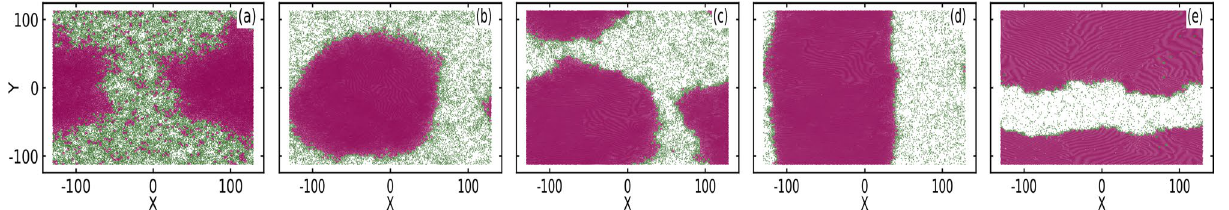
Figure 2. Configuration of the system for ( a ) κ in the low and high density phase are colored green and magenta, respectively. Inertial parameters are fixed at 0.05 and J 2.0 , and the Peclet number is fixed at P M = = are stretched along one of the dimensions and become rectangular with increase in disk hardness.